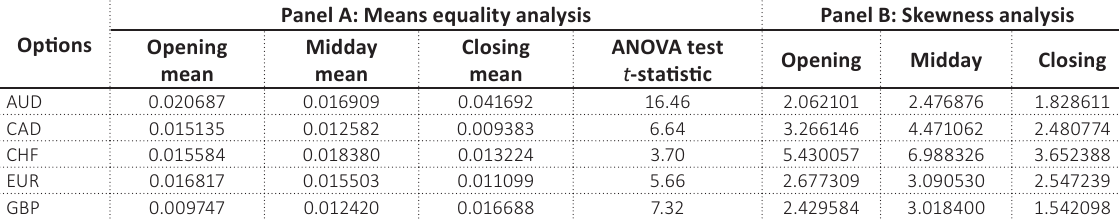
Table 2. Descriptive analysis of the currency smirk Panel A: Means equality analysis Panel B: Skewness analysis Options